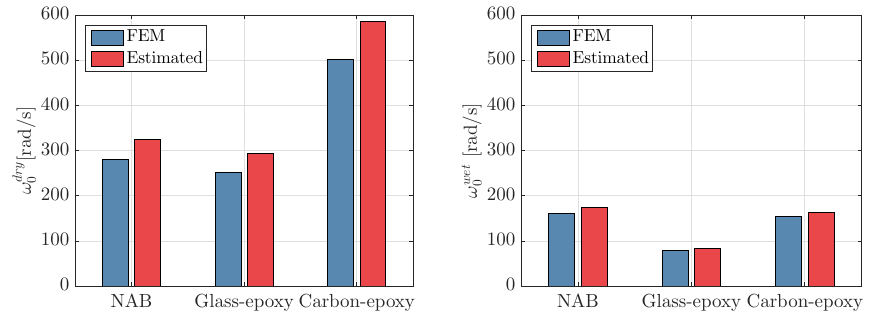
Figure 2. Dry and wet fundamental blade frequencies of the Seiun–Maru propeller for different blade materials obtained with FEM and estimated with Equations (1) and (2).